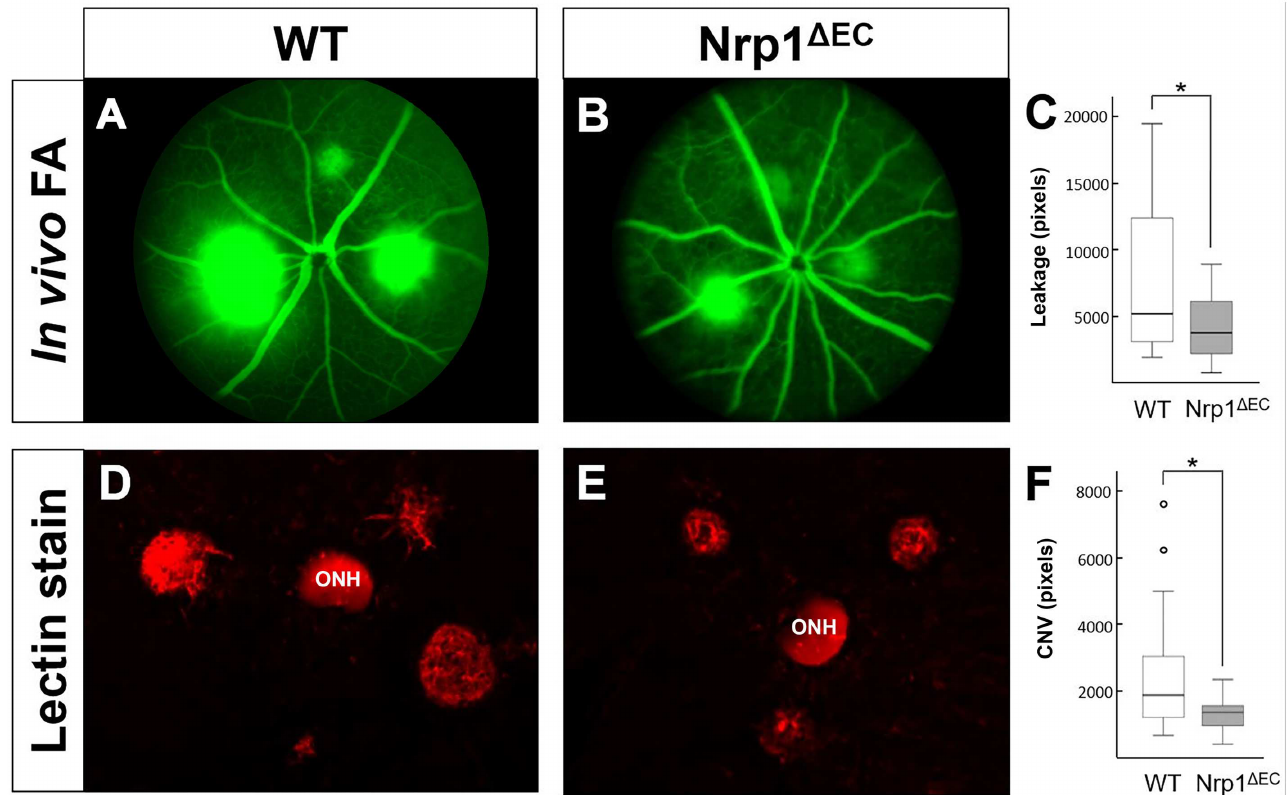
Fig 3. Laser-induced CNV assessed by fluorescein angiography and wholemount staining. In vivo FA images (A and B) and quantification of fluorescein leakageareas (C) one week after CNV inductionshowedstronger leakagein wild type (A) comparedto Nrp1 Δ EC (B) mice (p < 0.05;n = 5). Postmortem lectin staining(D and E) and CNV area quantification (F) one week after CNV inductionalso showedmore pronouncedpathologyin wild type animals(p < 0.05;n = 7). ONH indicatesthe optic nerve